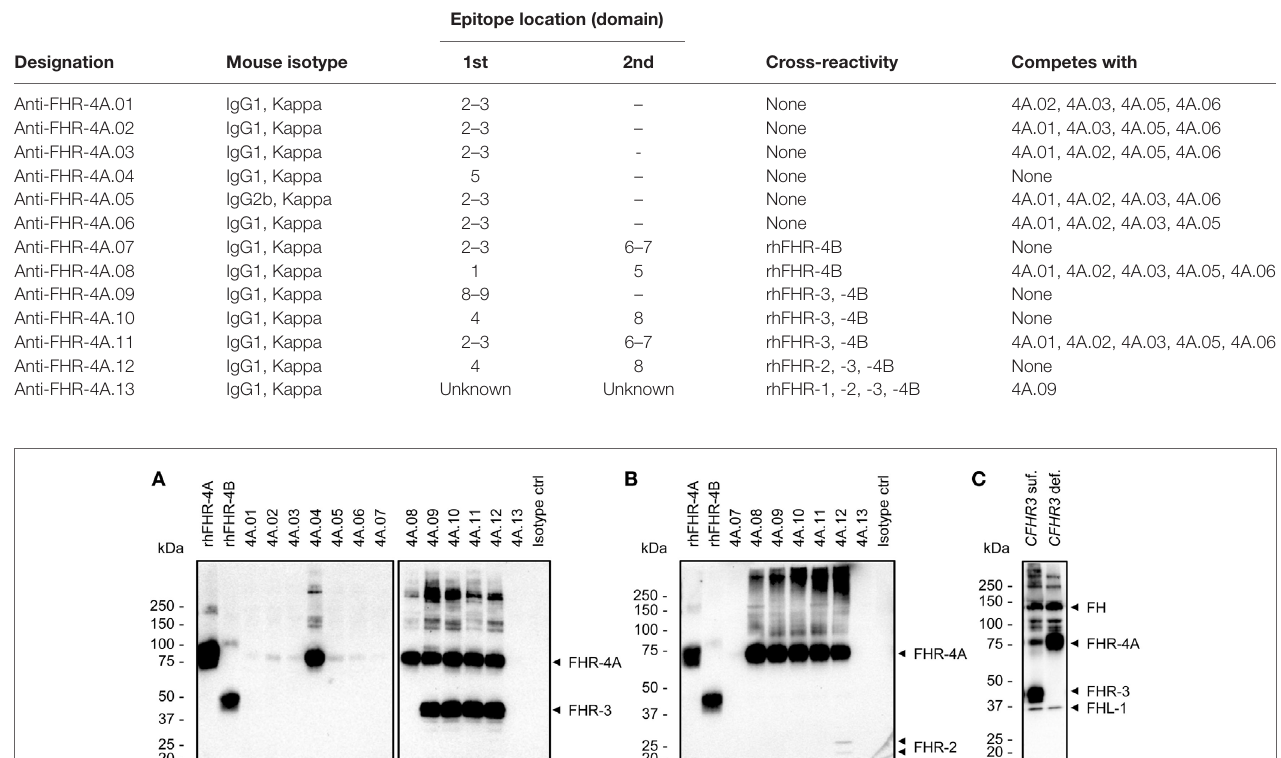
TaBle 1 | Anti-factor H-related (FHR)-4A monoclonal antibodies characterized in this study. epitope location (domain)